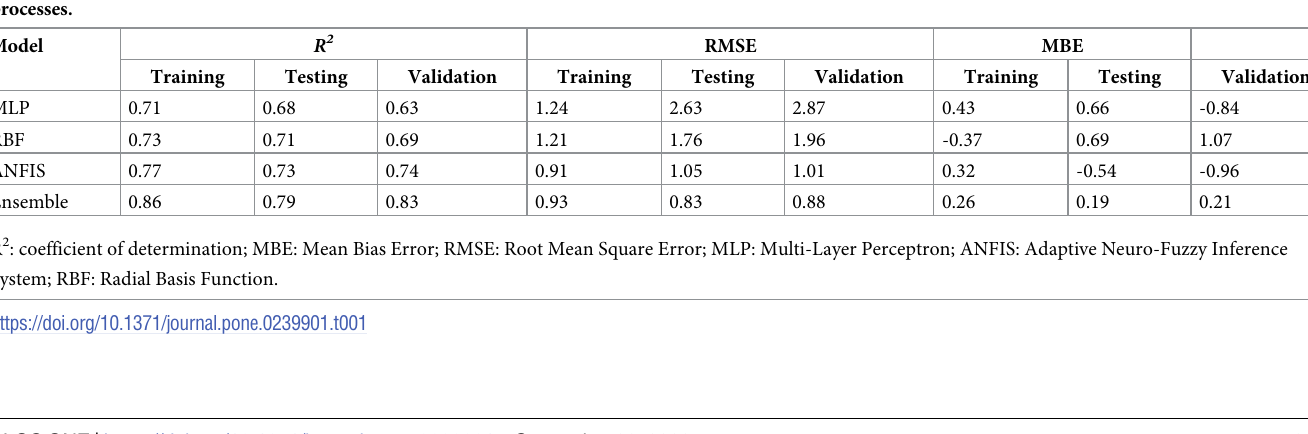
Table 1. Performance criteria of individual and ensemble models for gene transformation efficiency of chrysanthemum in training, testing, and validation processes. Model R 2 RMSE MBE Training Testing Validation Training Testing Validation Training Testing Validation MLP 0.71